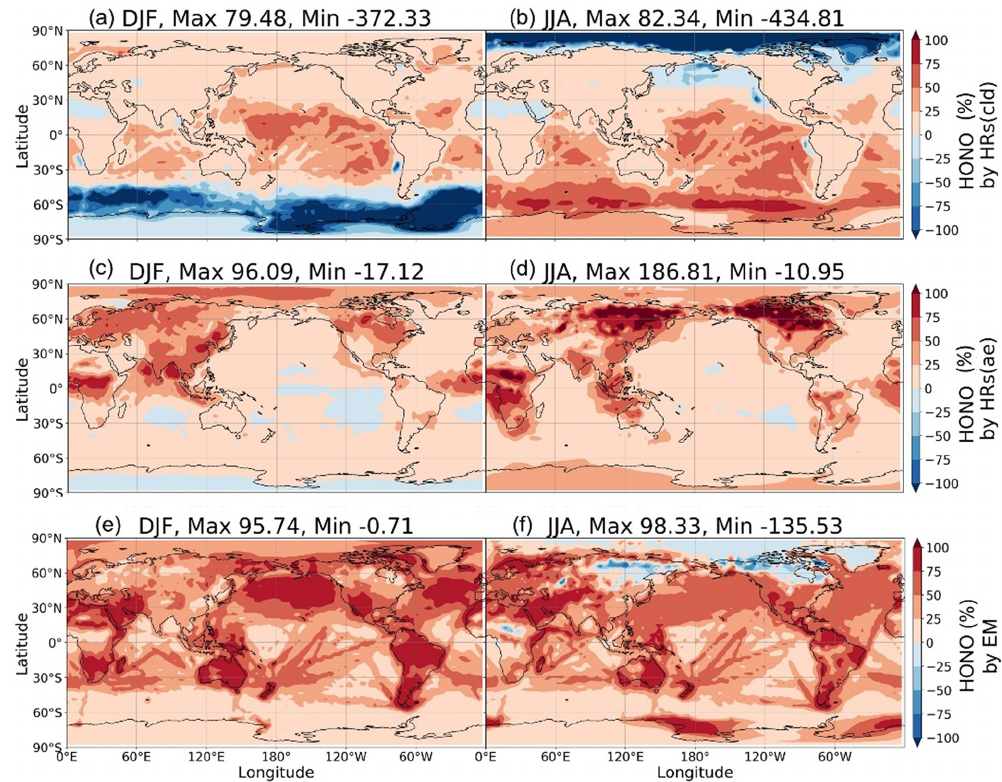
Figure 12. Contribution of HRs and EM to surface HONO concentrations. Contributions of HRs onto ice and clouds (a, b) , HRs onto aerosols (c, d) , and EM (e, f) in DJF (a, c, e) and JJA (b, d, f) are plotted. Each contribution is determined by the difference of HONO in two simulations: (a, b) GR + HR(cld) and GR; (c, d) GR + HR and GR + HR(cld); and (e, f) STD and GR + HR, divided by HONO in the STD case. The maximum and minimum values are out-scaled and hence displayed at the top of each